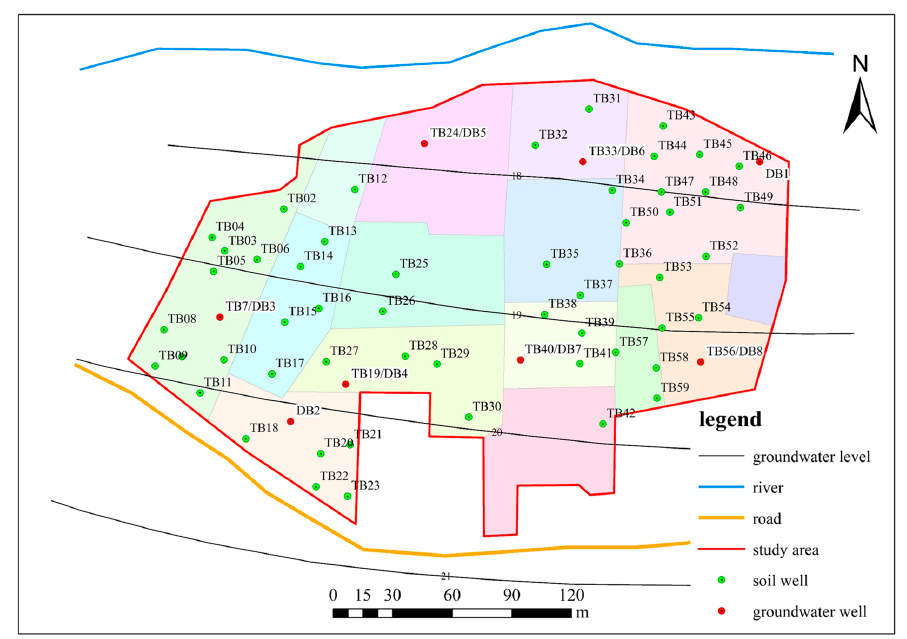
Figure 3. Layout of soil and groundwater points in the study area.